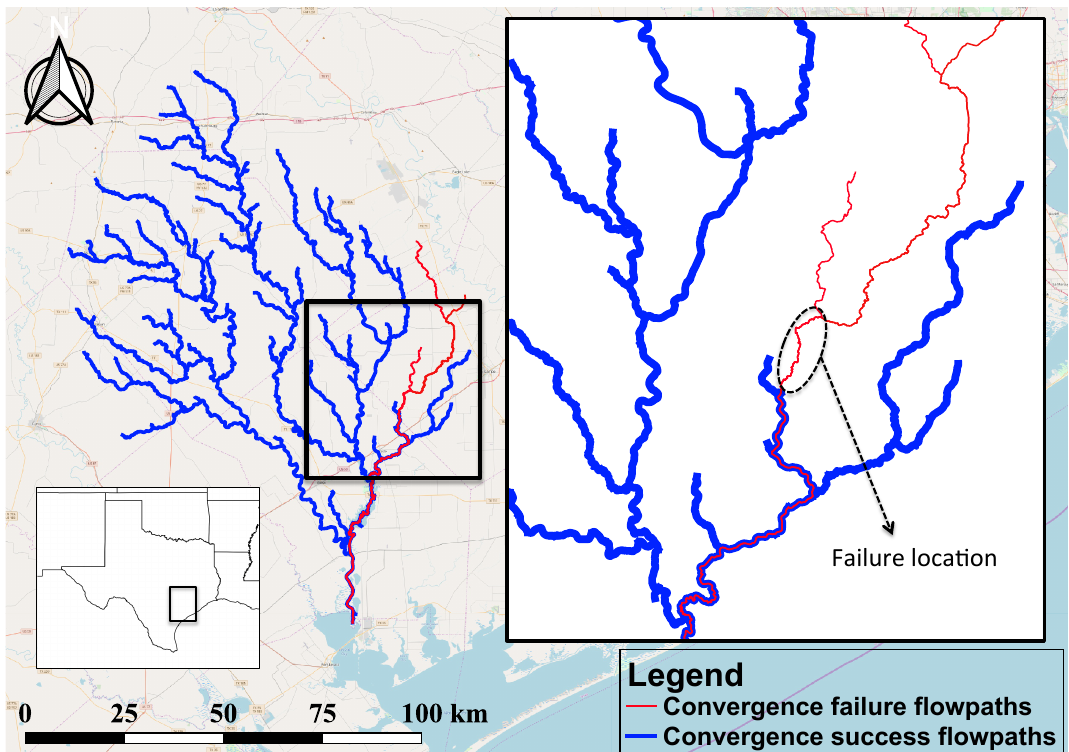
Figure 7. The map of the Lavaca River network and the problematic channel segment identified by the SSA